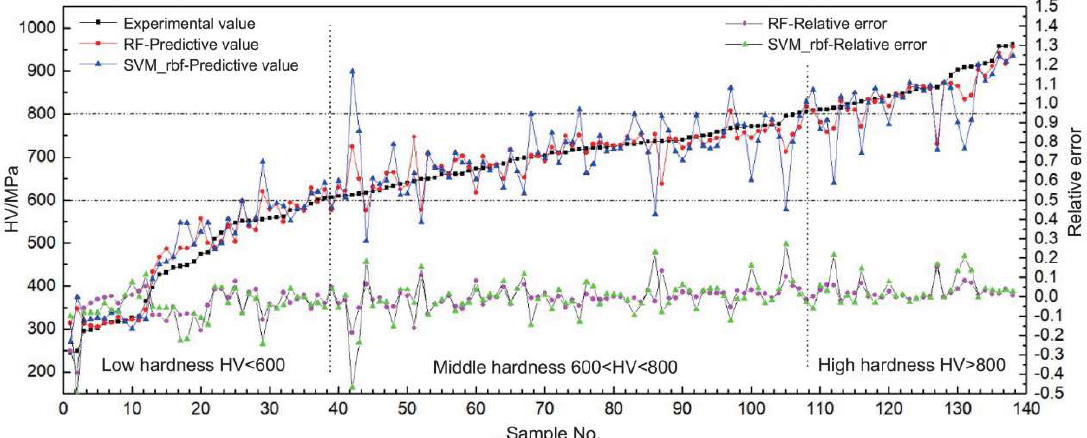
Figure 3. Experimental values, predictive values, and relative errors of predictive values to the hardness of 138 alloy samples. Reprinted (adapted) with permission from WANG [20]. Copyright 2020 Materials China.